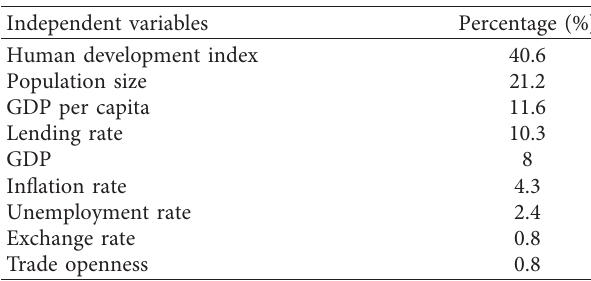
Table 6: Feature importance indicators.